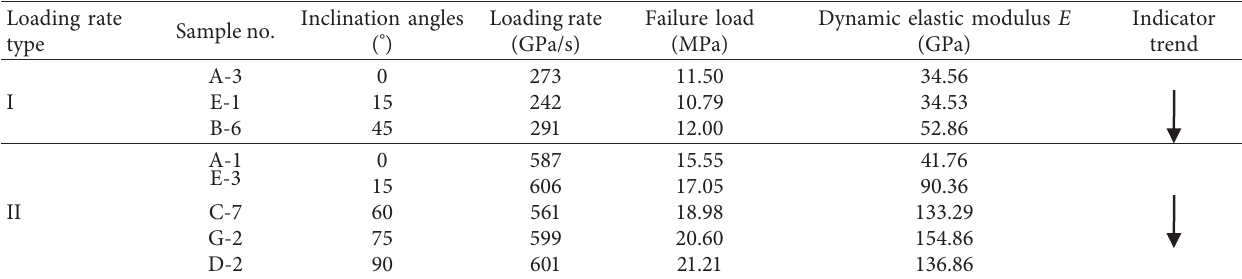
Figure 9: Stress and strain under different inclination angles. (a) The stress-strain curves of 0 ° , 15 ° , and 30 ° at approximately 240GPa/s. (b) The stress-strain curves of 0 ° , 15 ° , 60 ° , 75 ° , and 30 ° at approximately 600GPa/s. Table 4: The relationship between bedding inclination angle β and tensile strength σ and dynamic elastic modulus E (I;is the loading rate about 240GPa/s; II is the loading rate about 600GPa/s).